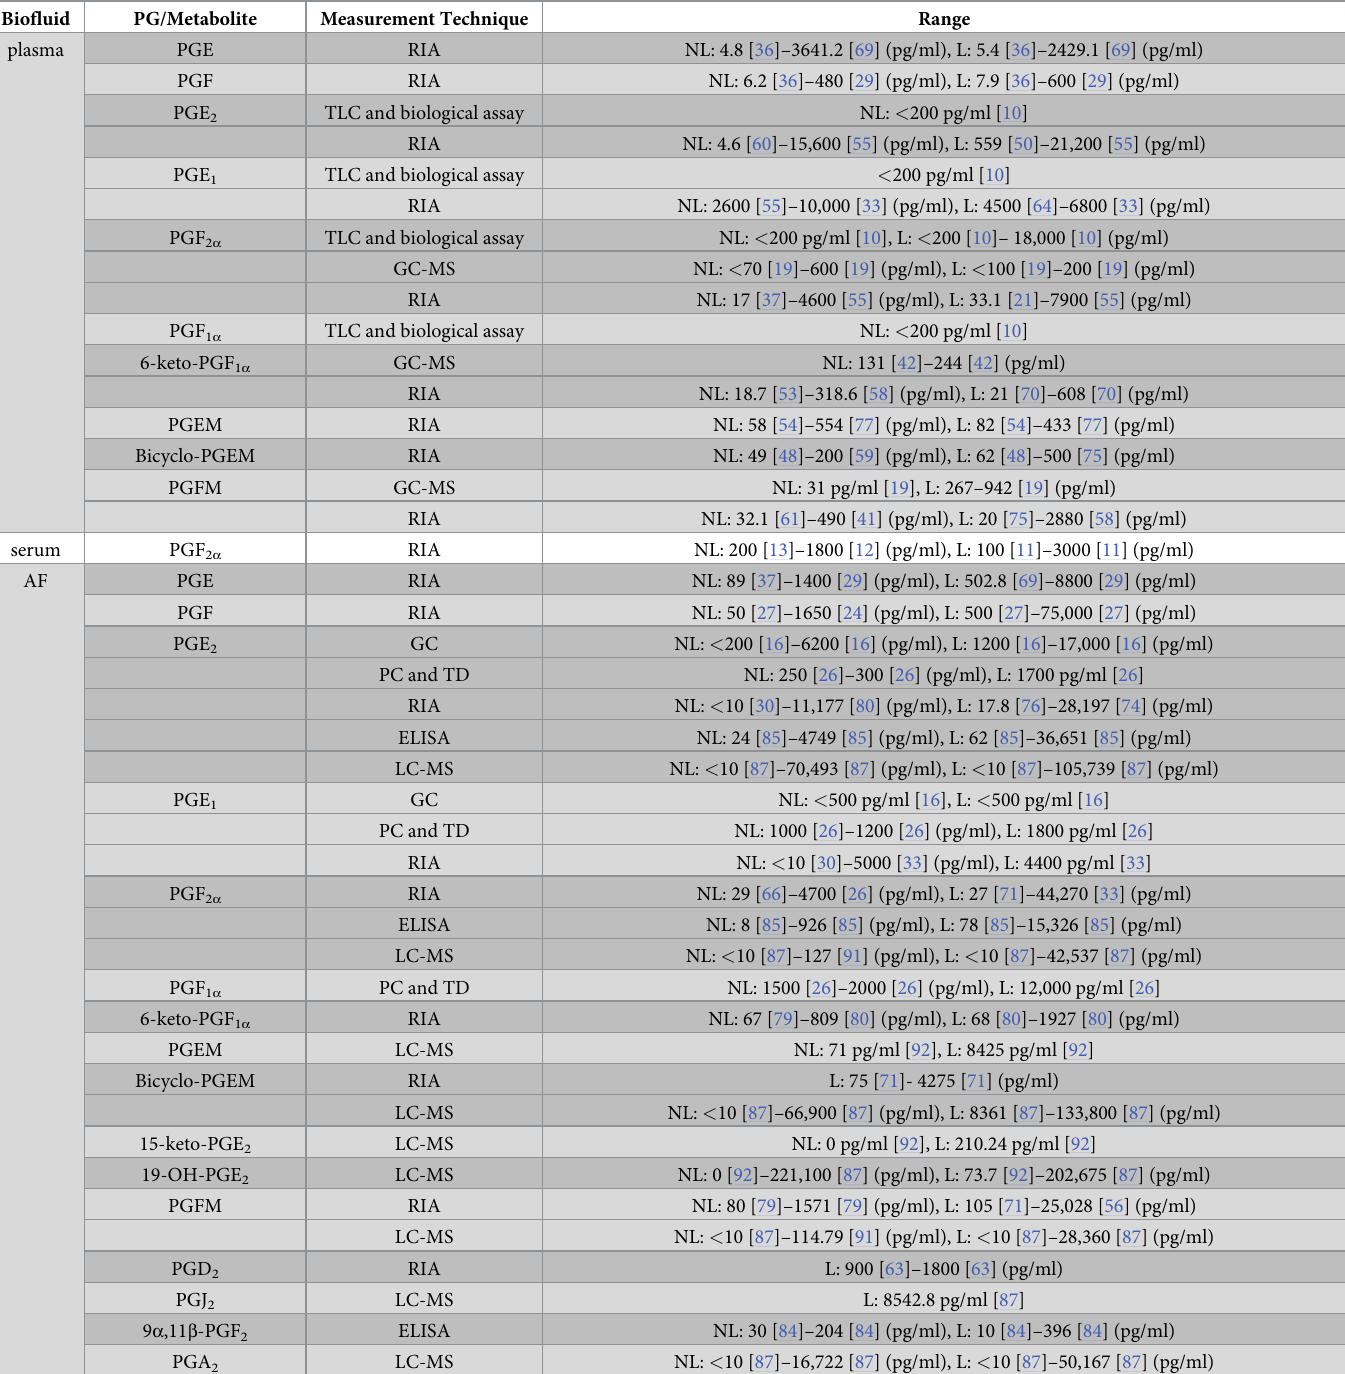
Table 3. Range of prostaglandin concentrations reported using different measurement techniques.